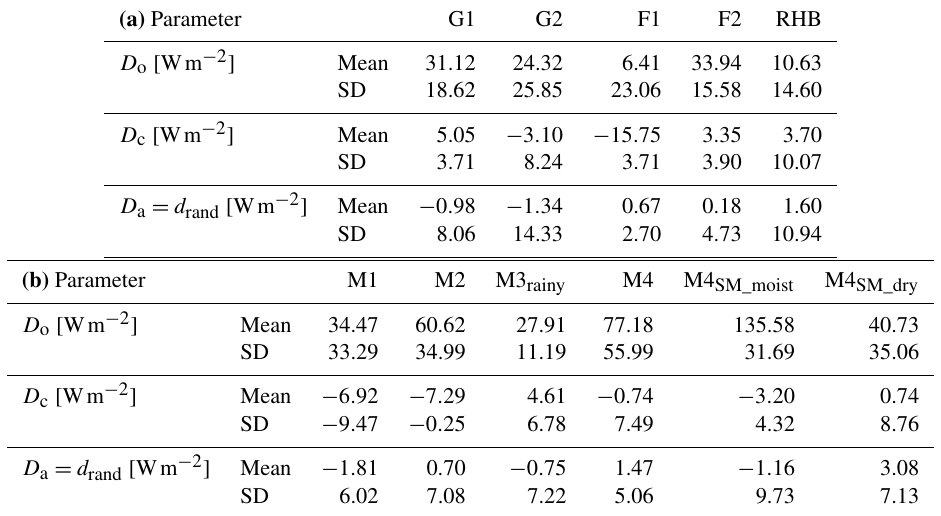
Table 3. (a) Parameter differences (LY − EC) for humid stations. (b) Parameter differences (LY − EC) for Majadas station; semiarid.